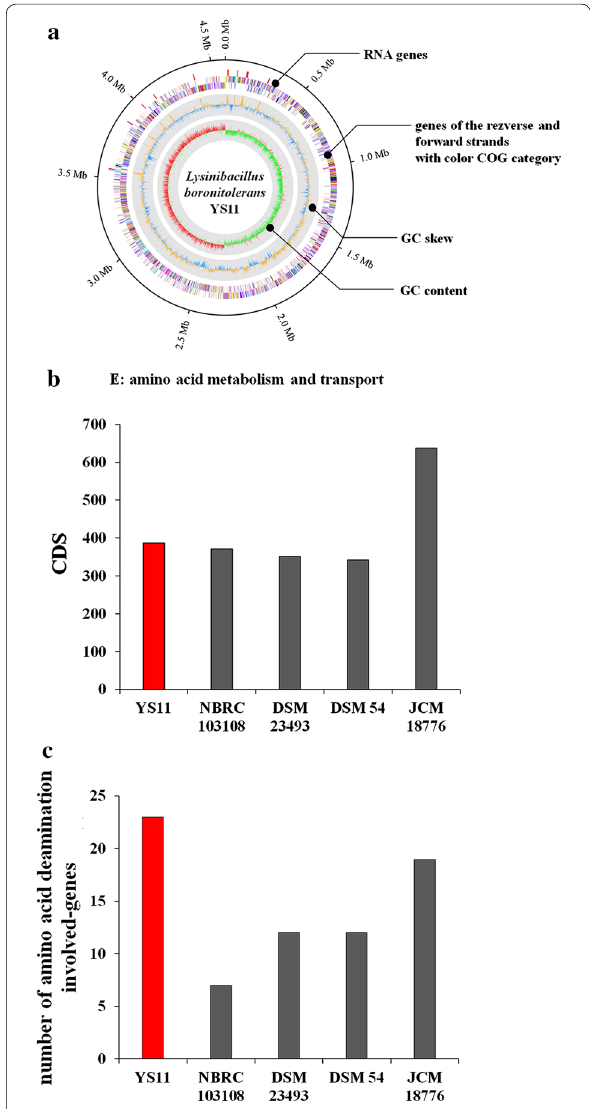
Fig. 1 a Circular genomic map of Lysinibacillus boronitolerans YS11. From the outside to the center are RNA genes, genes of the reverse strand, genes on the forward strand, GC ratio, and GC skew. Genes are colored according to their COG category. b Number of CDSs belonging to amino acid metabolism and transport group from YS11 with other Lysinibacillus species including L.